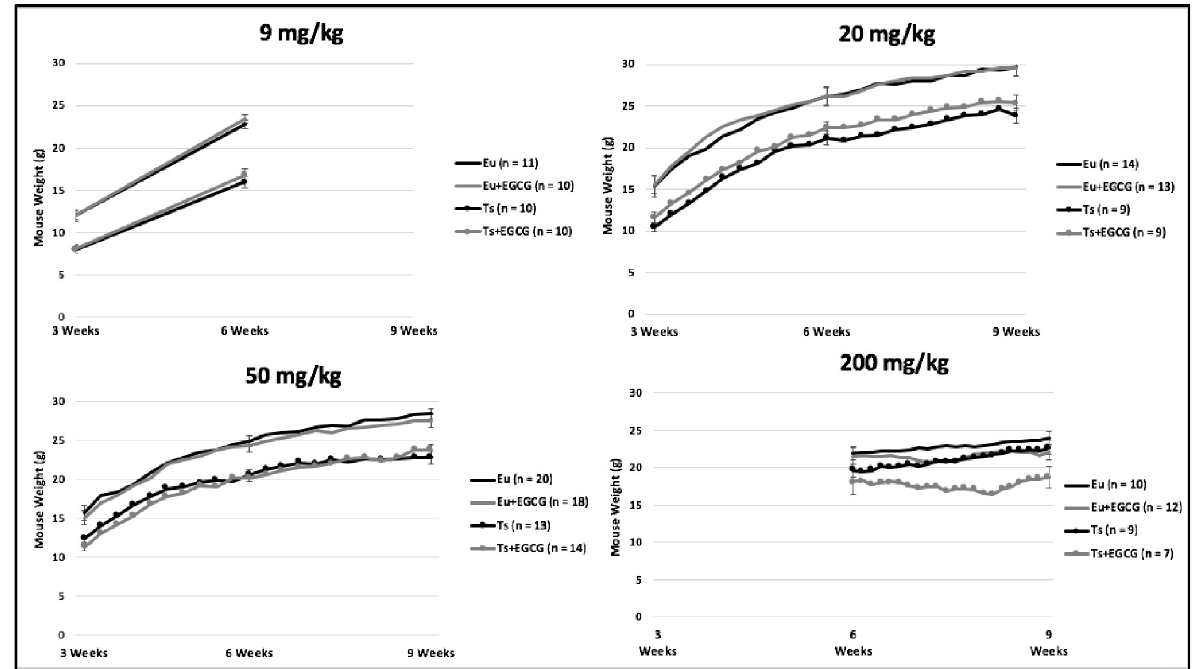
Fig 3. Weights of Ts65Dn (Ts) and Euploid (Eu) mice treated with EGCG or control fluid. Weights were taken at times indicated by the dots on the graphs of the Ts mice. Standard error of the mean (SEM) measurements given at 3, 6, and 9 weeks at times weights were